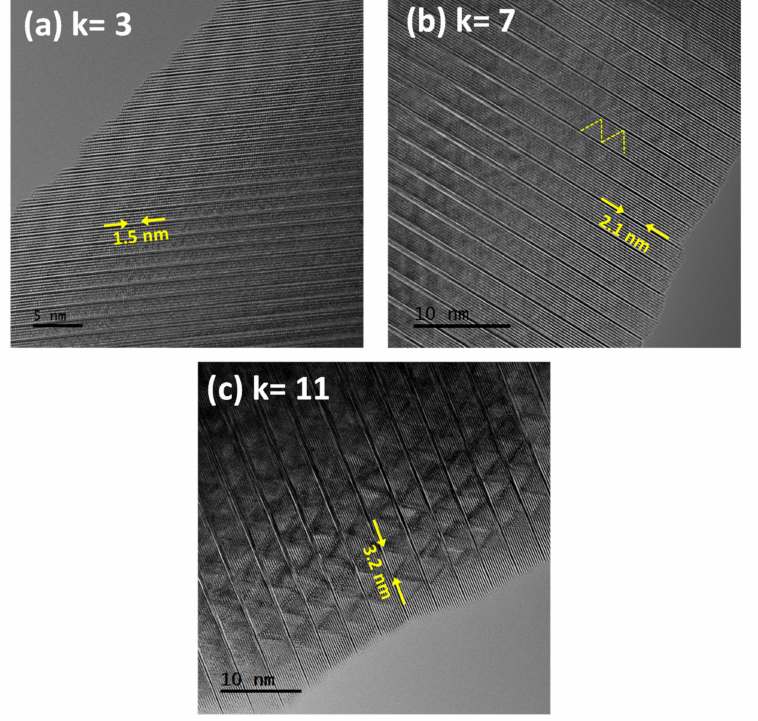
Figure 4. HRTEM images corresponding to ( a ) k = 3, ( b ) k = 7, and ( c ) k = 11 along the [110] direction. Dashed yellow lines in the k = 7 term are marked for a better visualization of the zig-zag pattern. In each image, the periodicity of the modulation is